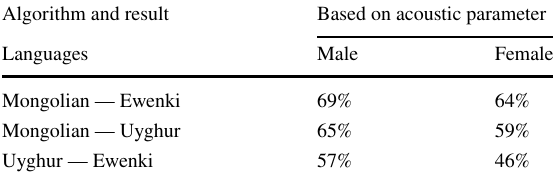
Note : distance similarity comparison of F1 and F2 of vowels in the